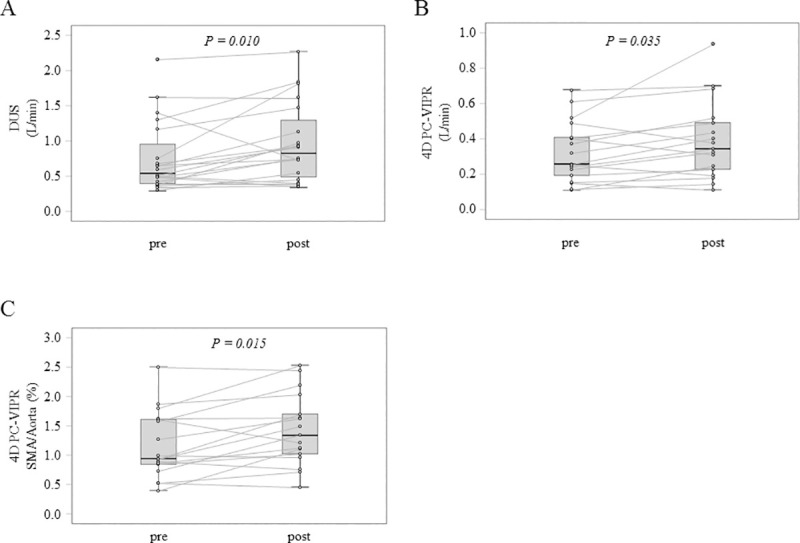
Blood flow volume of SMA.(A) Comparison by actual measurement before and after oral administration in DUS (p = 0.010, Wilcoxon signed-rank test). (B) Comparison by actual measurement before and after oral administration in 4D PC-VIPR test (p = 0.035, Wilcoxon signed-rank test). (C) The ratio of the SMA FV to the aorta, before and after oral administration on 4D PC-VIPR test (p = 0.015, Wilcoxon signed-rank test).